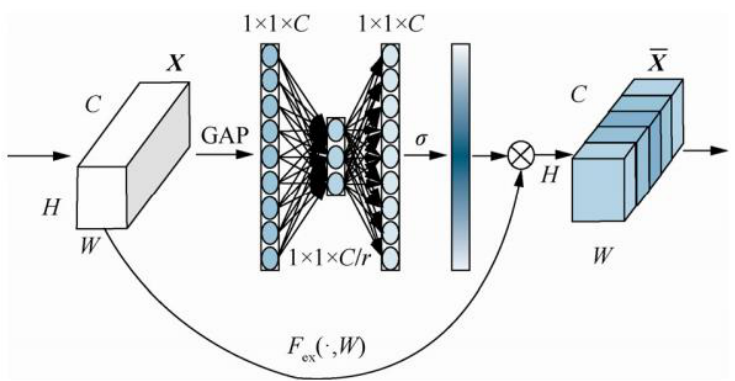
⊗ is element-wise